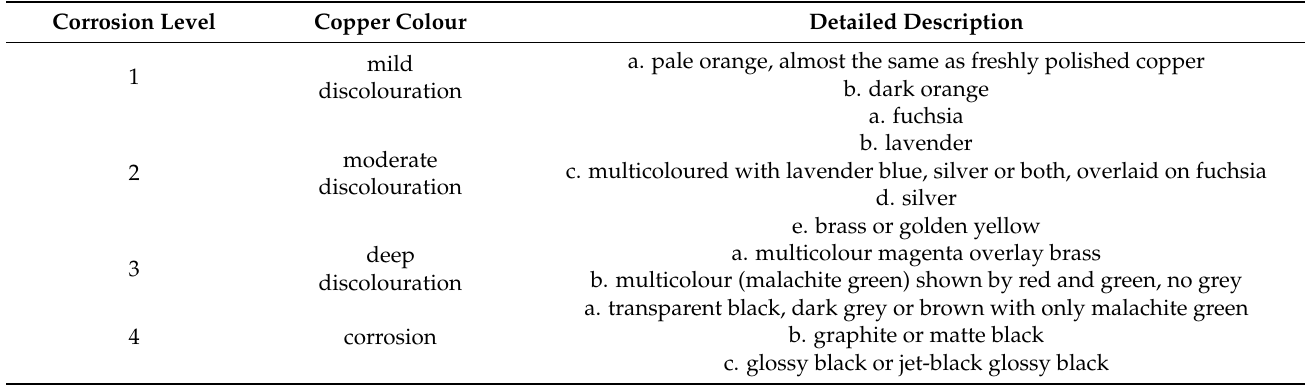
Table 2. The grading table of copper corrosion standard swatches